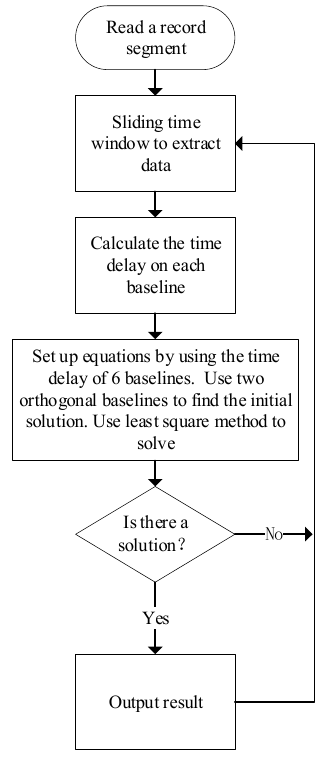
Figure 1. The 2-D locating calculation flow chart.